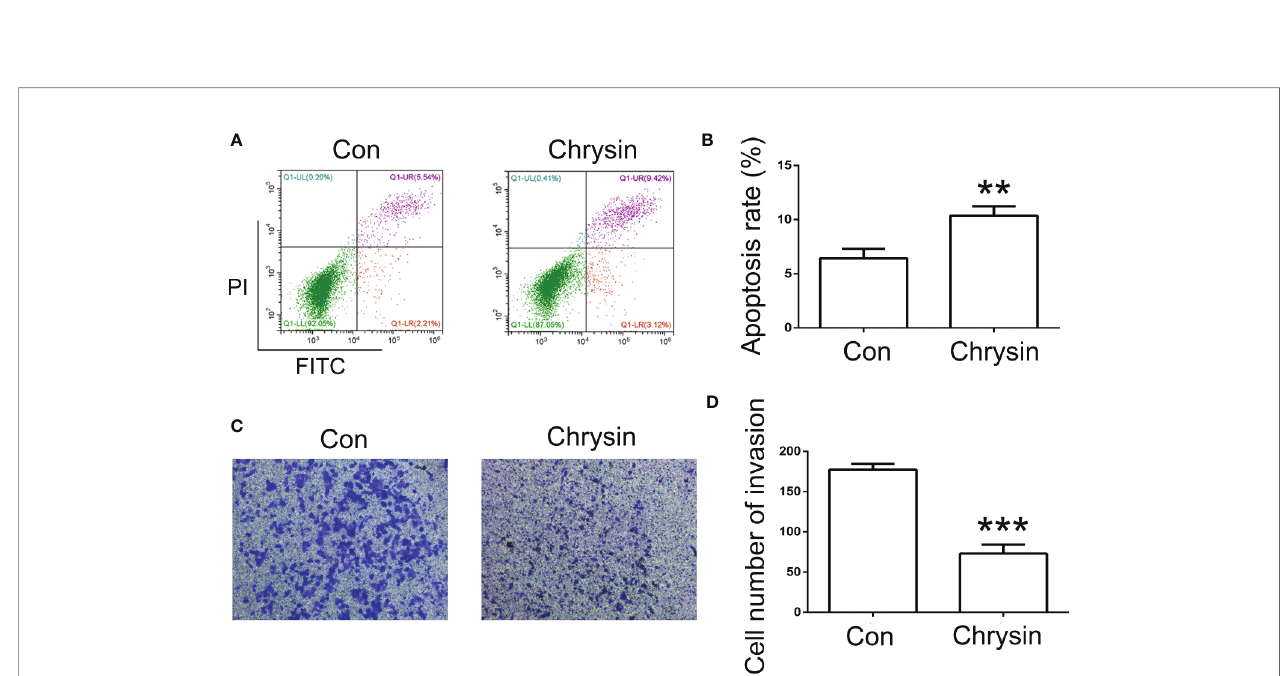
FIGURE 3 | Analysis of cell apoptosis and invasion after chrysin treatment. The cell apoptosis was analyzed between Con and chrysin group (A) . Statistical analysis of the percentage of cell apoptosis (B) . The cell invasion was analyzed (C) . Statistical analysis of the percentage of cell invasion (D) . The data are represented as the mean ± SD (n = 3). ** ( p < 0.01) and *** ( p < 0.001) indicate statistically signi fi cant differences.